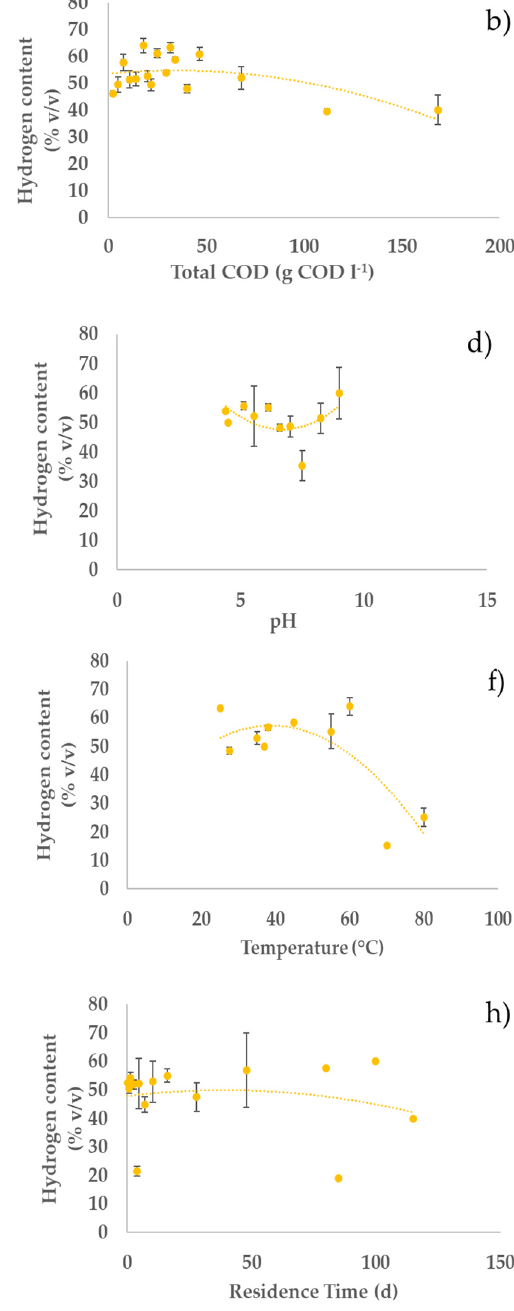
Figure 3. Relationships between hydrogen content in biogas and operating parameters: ( a , c , e , g ) all the considered experiments; ( b , d , f , h ) average values of experiments in each narrow range (width maximum 20%) of the operating parameters (error bars indicate the standard error) with second-order polynomial curve. The polynomial curve is only used to visualise the general trend, without any statistical significance.